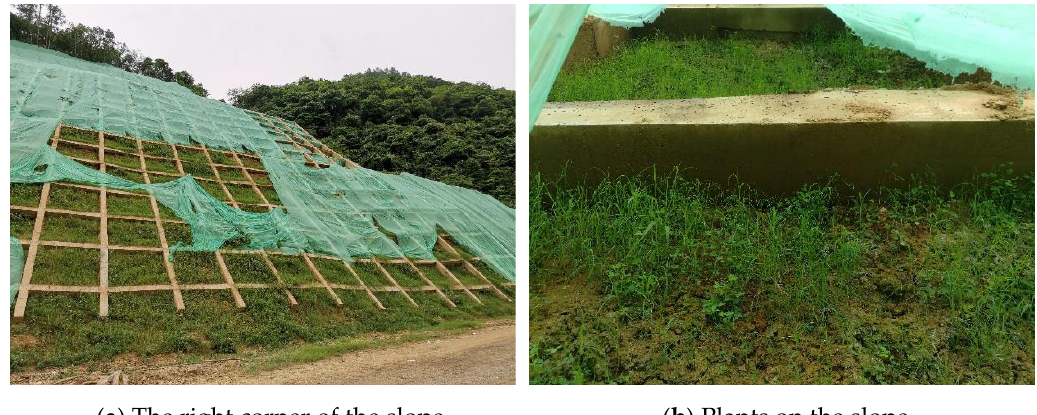
( a ) The right corner of the slope. ( b ) Plants on the slope. Figure 17. Four months after Figure 17. Four months after construction.